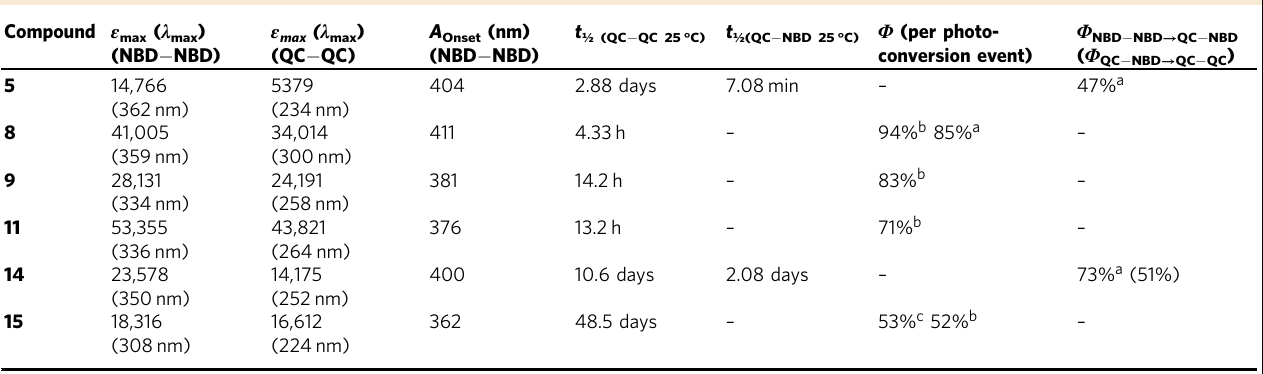
Table 1 Physical